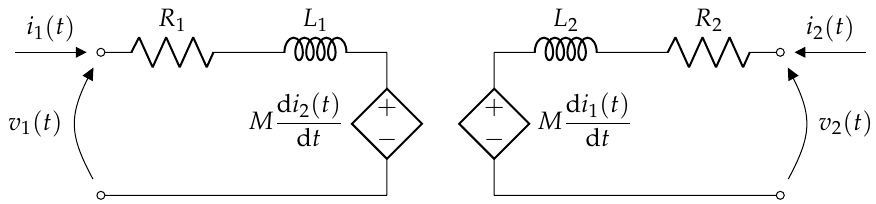
Figure 2. Equivalent circuit of the rotary transformer with mutual